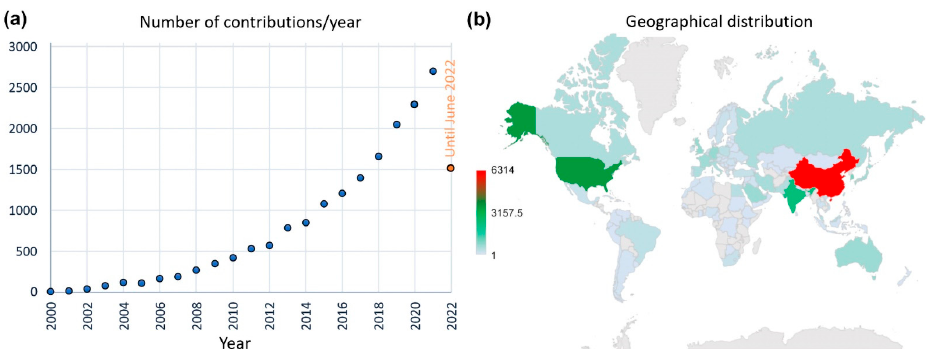
Figure 1. Scientific contributions dedicated to energy nanomaterials: ( a ) documents published since 2000 and ( b ) their geographical distribution. Keywords: “energy” AND “nanomaterials” within: Article title, Abstract, Keywords (Source: Scopus; May 2022).